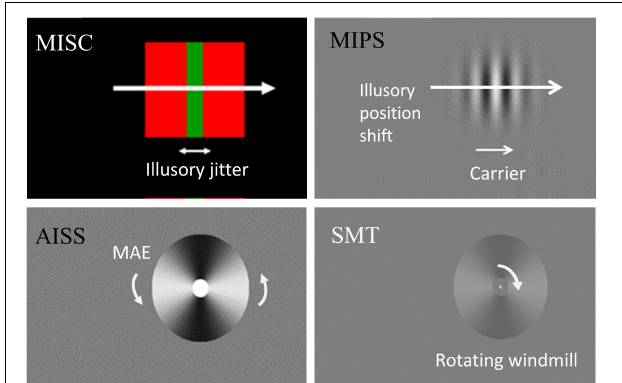
FIGURE 1 | Stimulus illustration and measurement. In MISC, the equiluminant chromatic (red and green) edge and high luminance contrast (red and black) edge move together, producing an illusory jitter whose frequency is related to the MEG alpha oscillation frequency. In MIPS, the carrier movement in a static envelope leads to an illusory position shift of the envelope in the carrier motion direction. In AISS, motion adaptation induces an illusory spatial shift in the direction of the motion after-effect (MAE). In SMT, there is an upper threshold for perceiving “smooth rotation”, above which motion becomes turbulent. We measure a rate in each task – the illusory jitter frequency in MISC, the accrual rate of the illusion in MIPS and AISS, and the upper smooth motion threshold (temporal frequency) in SMT. See Supplementary Movies 1, 2 for a demonstration of the MISC and AISS